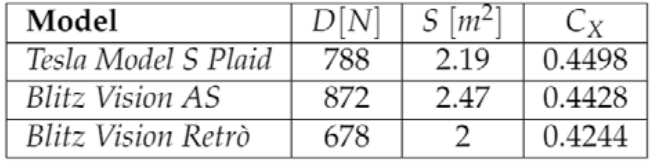
Figure 18. Pressure contour and streamlines around the vehicle. As typically happens in vehicles, a separation bubble is formed where the hood and the windshield meet. In this region high turbulence and pressure are present, and for that reason it is common to locate the intakes for ventilation of the passenger compartment here. In order to reduce the entity of such a turbulence region, both models were modified in order to reduce as much as possible the inclination of the windshield. This solution, although being aerodynamically positive, reduces visibility. Since both vehicles surpassed the CFD analysis, the final model can be defined (Figure 19).